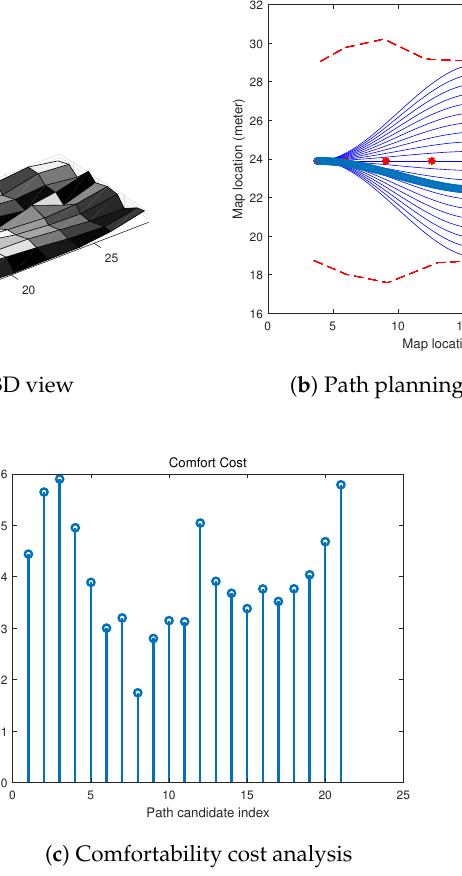
Figure 15. Multiple obstacle path selection: ( a ) a gray map of the XY view on obstacles; the light color indicates z > 0; the dark color indicates z < 0; ( b ) path selection result under all safe to pass bumps: the selected path finds the best path from the comfortability cost function; ( c ) path candidate comfortability cost analysis